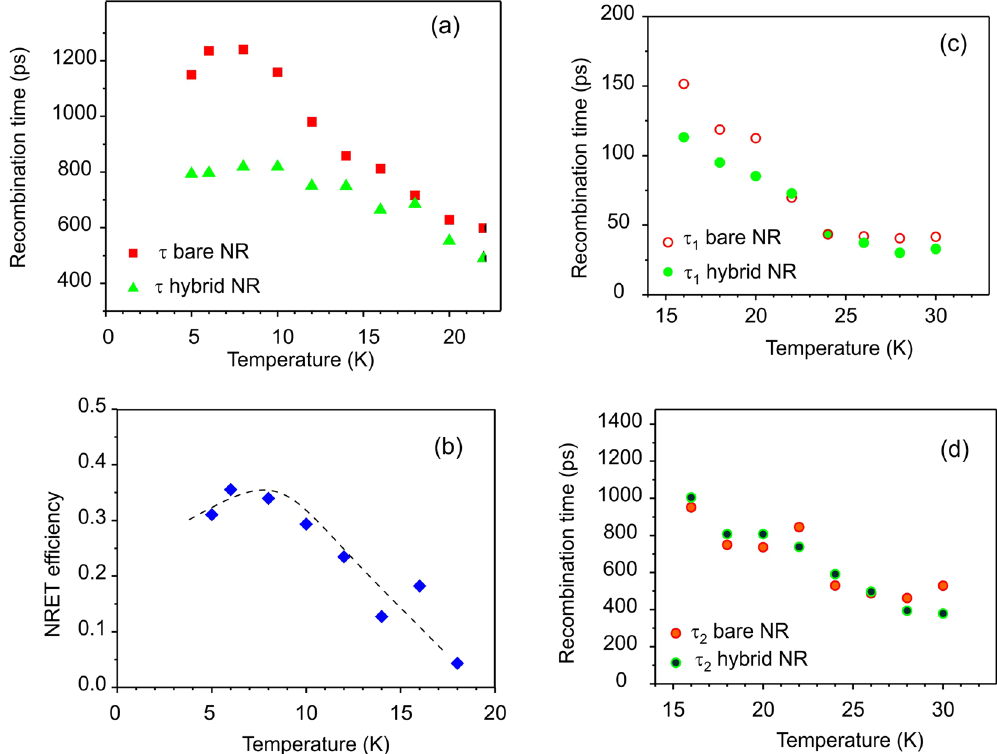
Figure 4. ( a ) Decay time extracted by a single exponential decay fitting for the SF related emission in as-grown sample (red squares) and in hybrid NR (green triangles). ( b ) Assuming NRET occurs, the efficiency of NRET is calculated by Eq. (2) using recombination data shown in ( a ). ( c and d ) Temperature dependence of the fast and slow recombination times, respectively, extracted for the SF emission using fitting by bi-exponential decay law. The dashed line is a guide to the